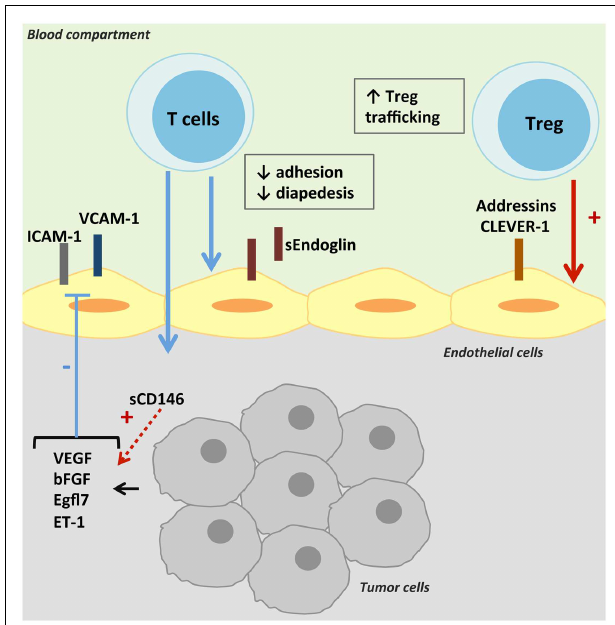
FIGURE 1 | Control of intra-tumoral immune cell trafficking by tumor endothelial cells .T-cell trafficking is reduced in tumors despite the secretion ofTNF- α . Pro-angiogenic factors present in the tumor microenvironment decrease the expression and/or gathering of adhesion molecules onTECs, and thusT-cell intra-tumoral infiltration.TECs can also express molecules specific ofTreg adhesion and transmigration, thus promoting anti-tumoral immune